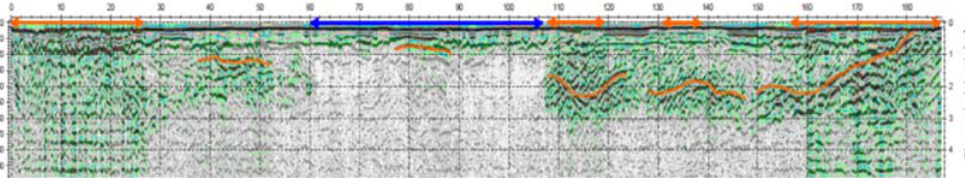
Figure 5. Result of the GPR monitoring. The orange arrows above the surface represent areas with heterogeneous material, blue arrow stands for high signal attenuation representing moist material or shallow layer with high clay